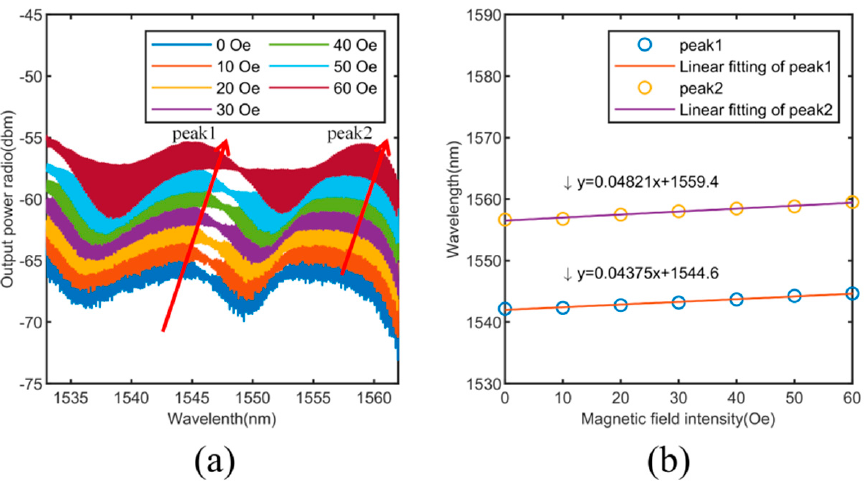
Figure 6. ( a ) Sample 2: Output spectrums under a magnetic field range of 0-60 Oe. ( b ) Linear fitting of characteristic wavelength (peaks) shifting for magnetic response.